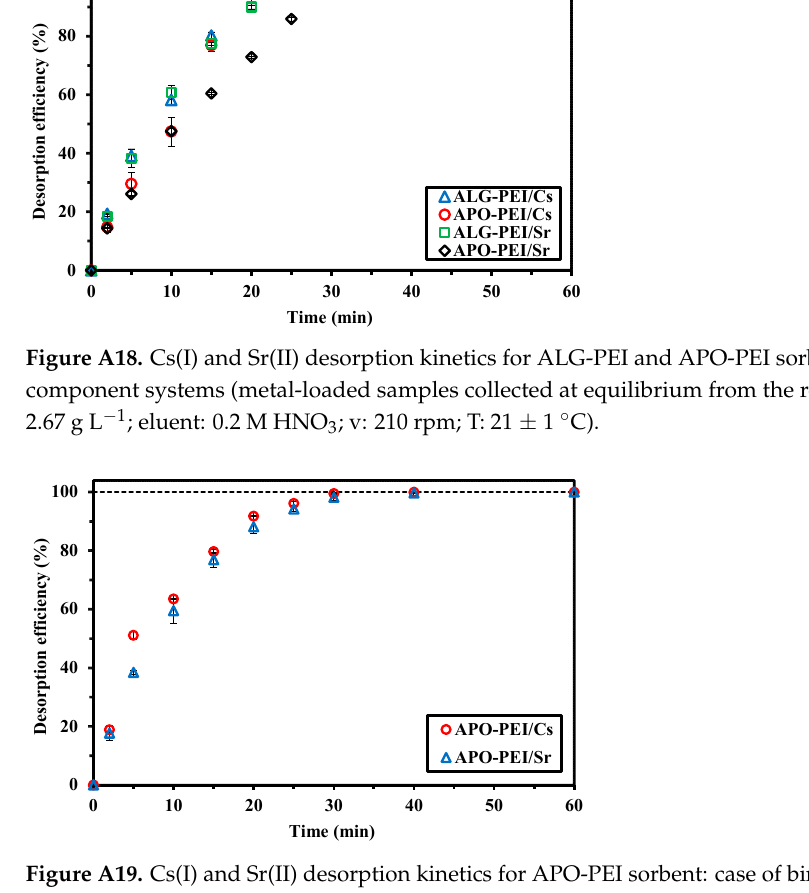
Figure A20. Location of sample collection (Beihai, China). Table A8. Composition of the seawater sample. Element